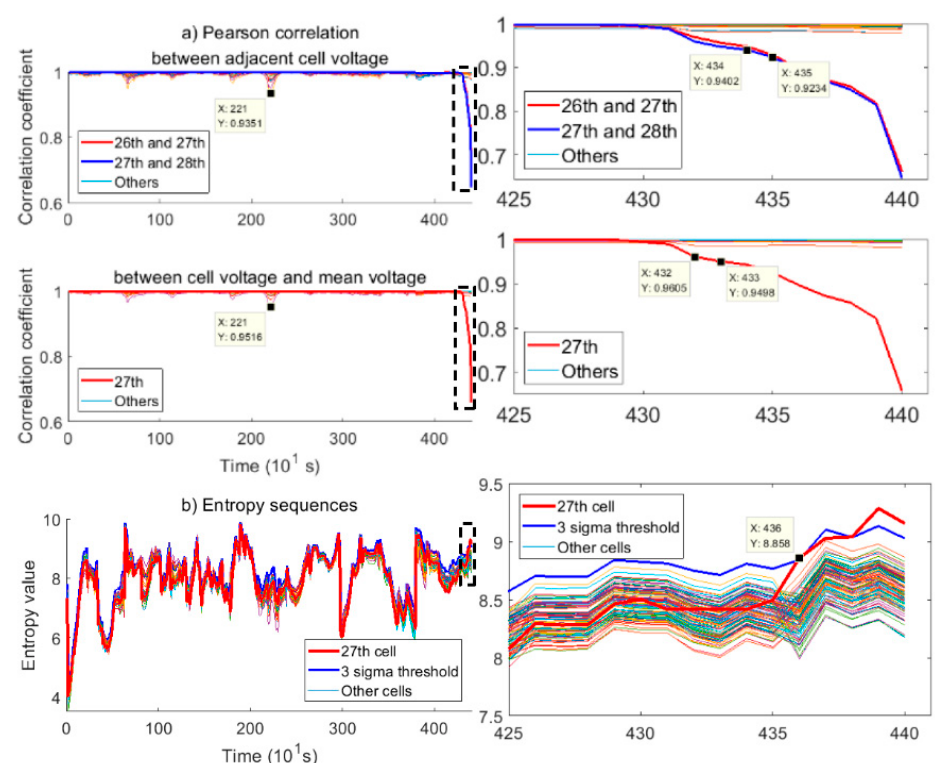
Figure 6. From the pre-fault dataset in the first case, ( a ) left: Sequences of Pearson correlation coefficients; right: Zoom-in of the parts bounded by dotted lines ( b ) left: Sequences of the entropy of normalized cell voltage data; right: Zoom-in of the part bounded by dotted lines.